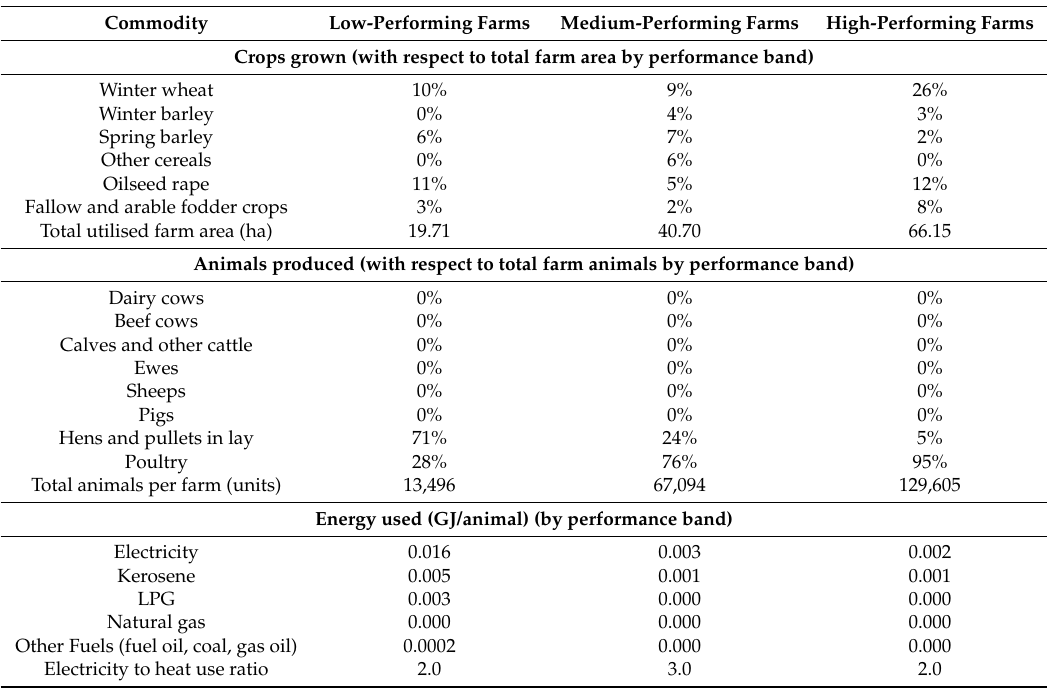
Table 7. Annual specialist poultry farm input and output characteristics [27].